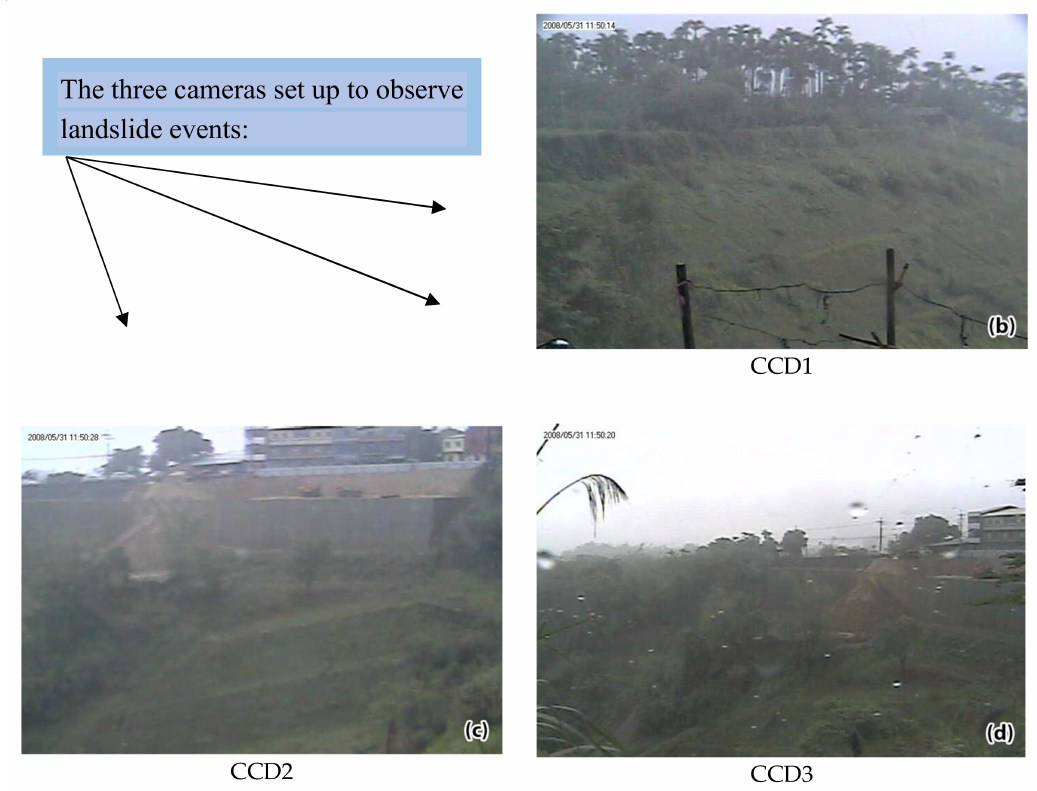
Figure 19. Relationship between rainfall and CCD data: ( a ) Cumulative rainfall of Pingding; ( b ) CCD camera 1; ( c ) CCD camera 2; ( d ) CCD camera